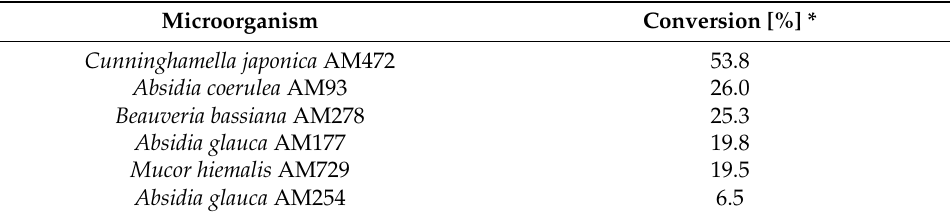
Table 5. Efficiency of wogonin 7-O- β -D-glucopyranoside ( 6 ) production by selected fungi. Microorganism